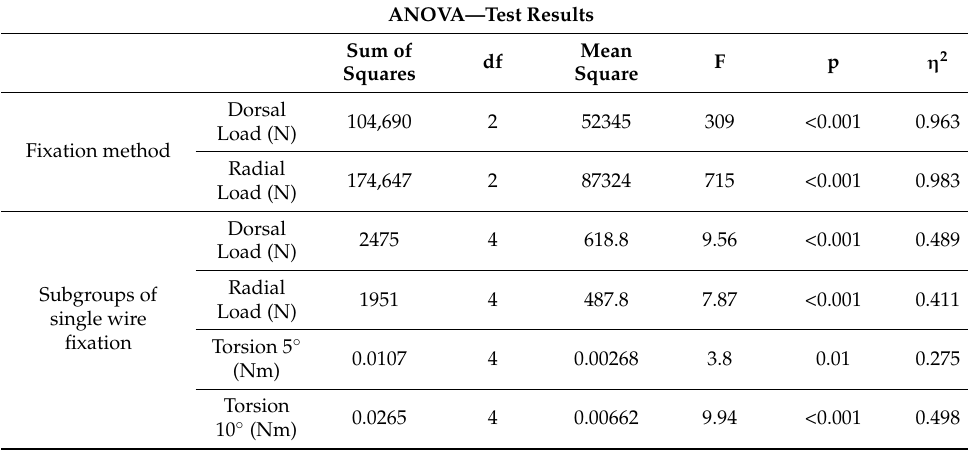
Table A3. Results of the ANOVA tests. The level of significance was set to 5% ( α =